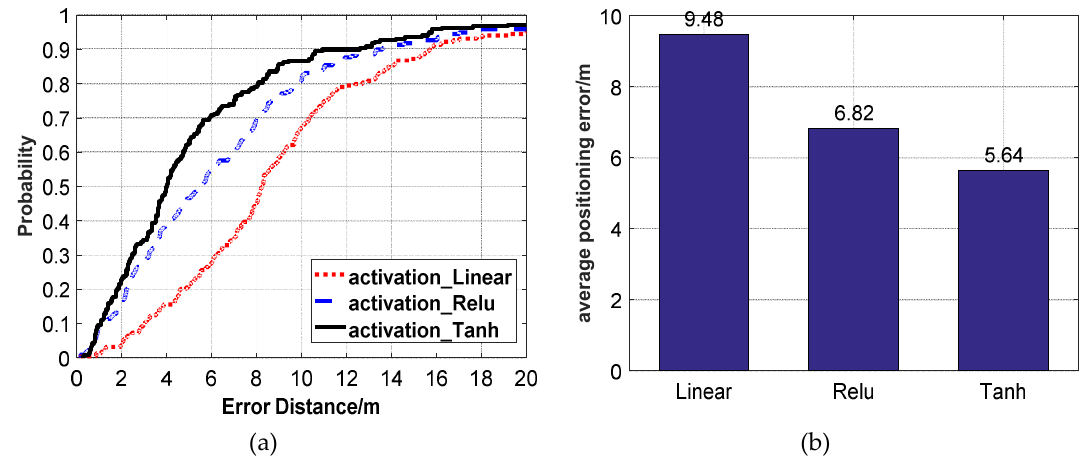
Figure 15. The positioning accuracy using different activation functions. ( a ) CDF positioning errors. ( b ) Average positioning errors.